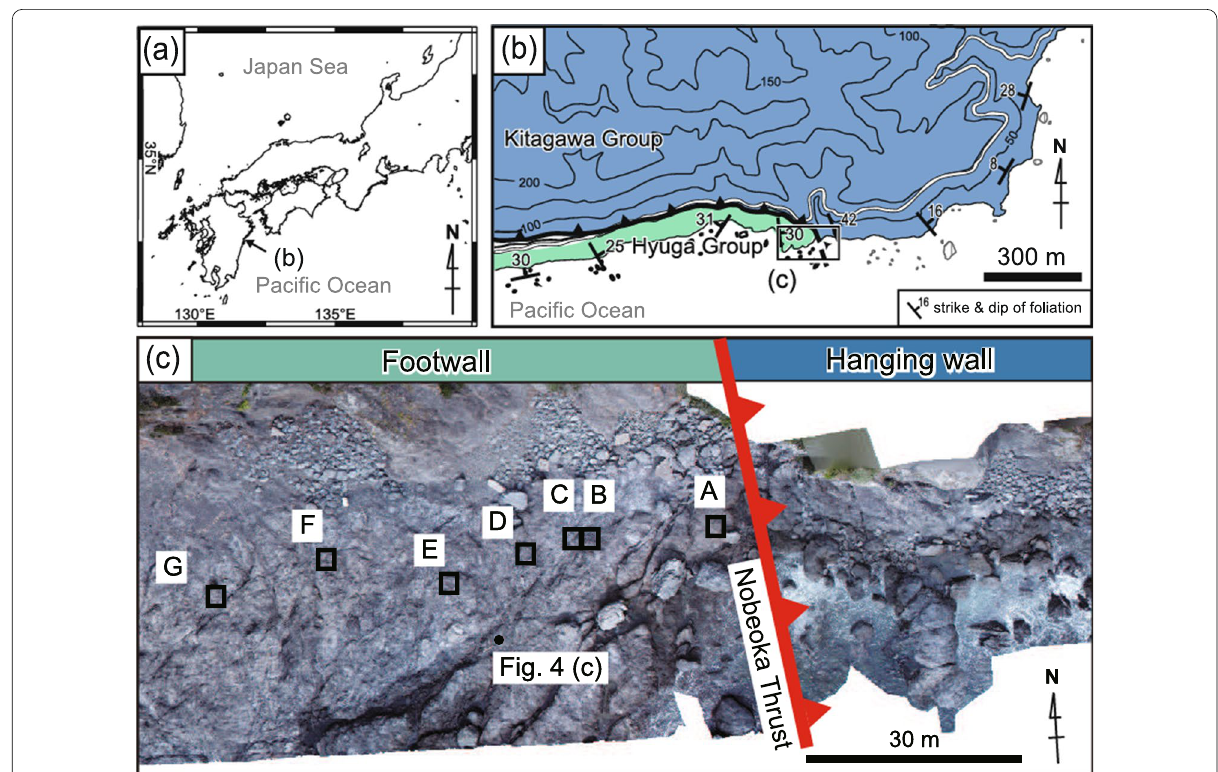
Fig. 2 a Location map of the research area. b Geological map of study area based on Yamaguchi et al. (2011) and Otsubo et al. (2020). c Image of three-dimensional spatial data of the study area. The solid squares indicate grids A–G, and the solid circles indicate the points of quartz vein samples for thin